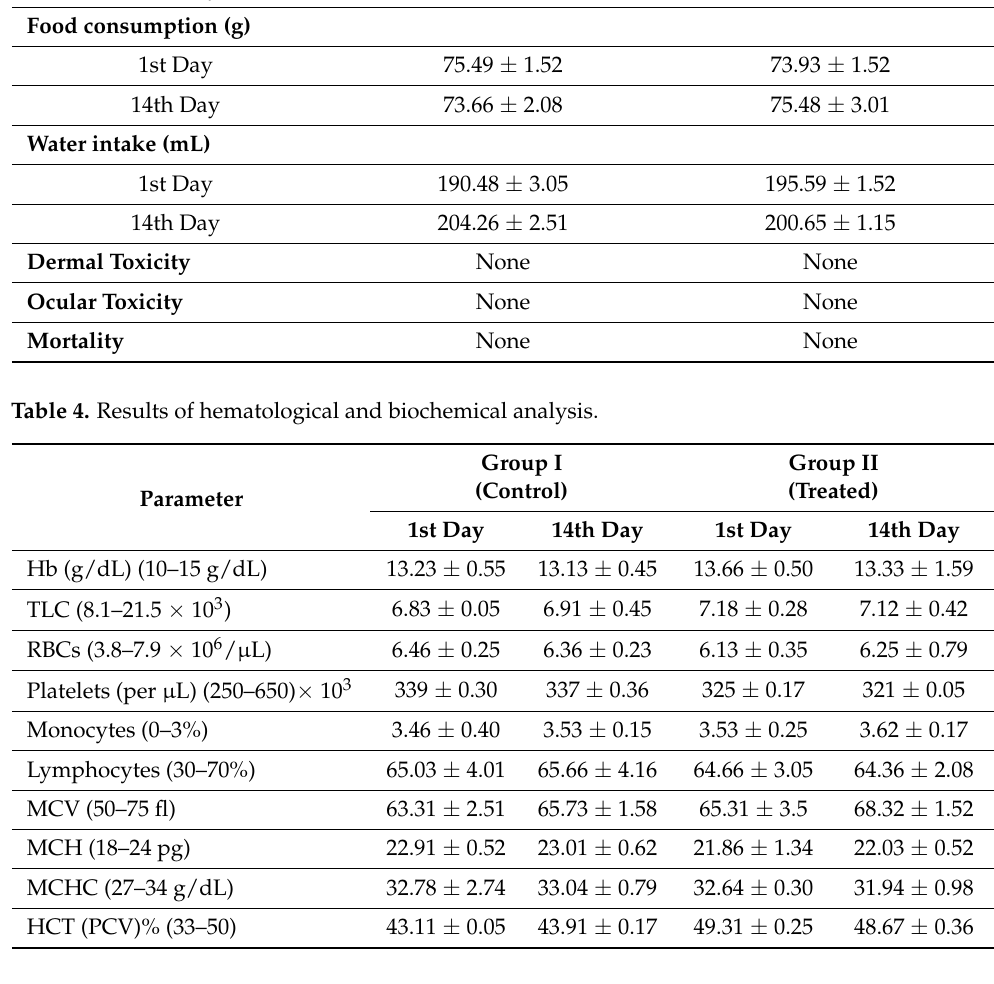
Table 5. Results of liver, kidney, and lipid